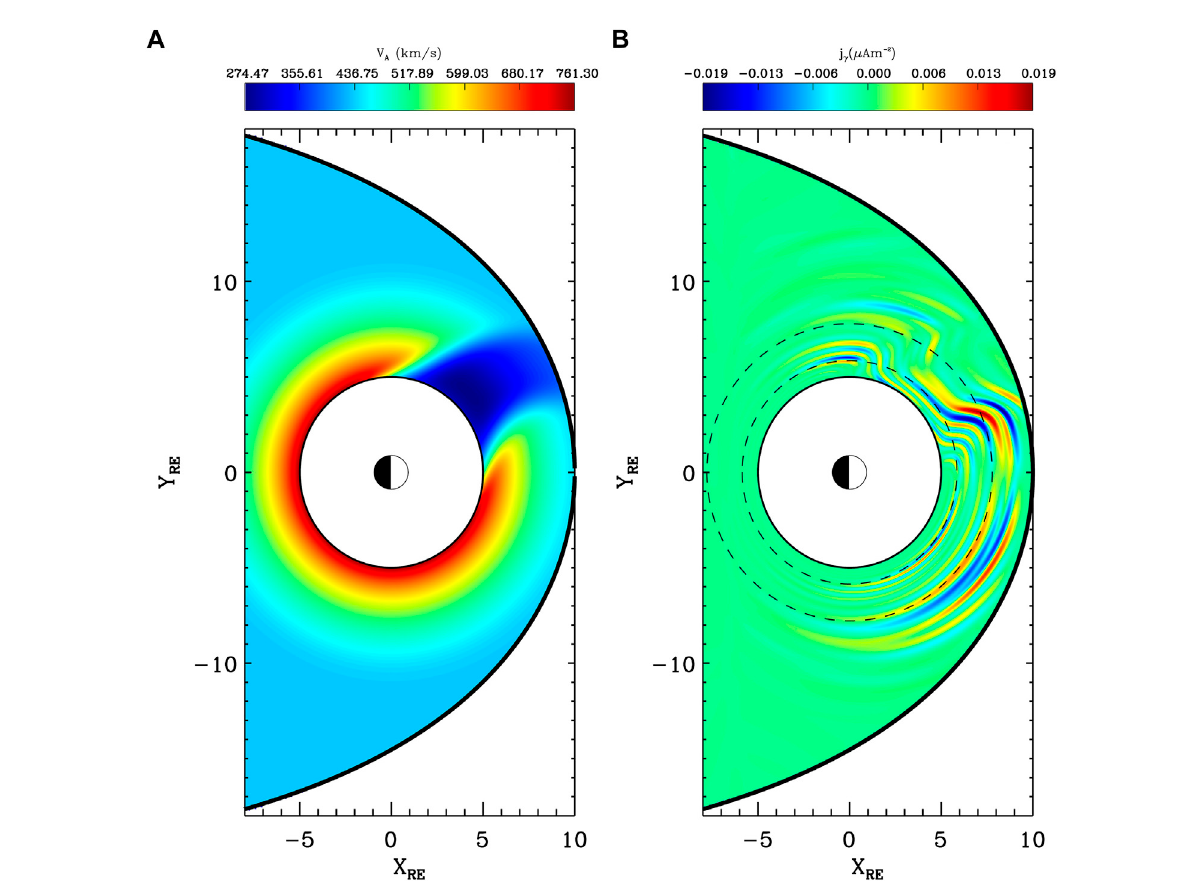
FIGURE 6 Reproduction of Figure 11 from Wright and Elsden (2020). (A) Contour of Alfvén speed in the equatorial plane. (B) Contour of fi eld-aligned currentdensity j γ closetotheionosphericendofthe fi eldline,mappedtotheequatorialplane.BlackdashedlinesareatconstantL-shell,at6and8 R E for